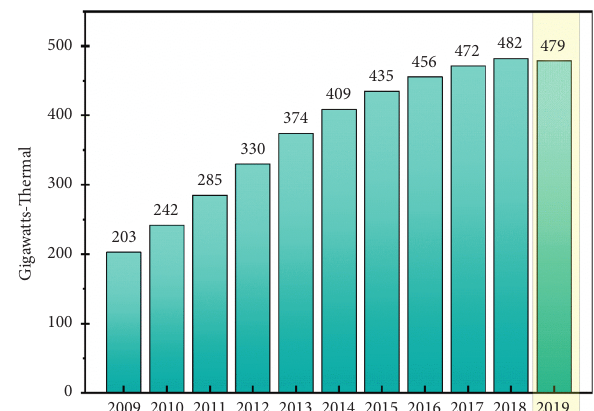
Figure 3: Solar water heating collectors’ global capacity, 2009–2019